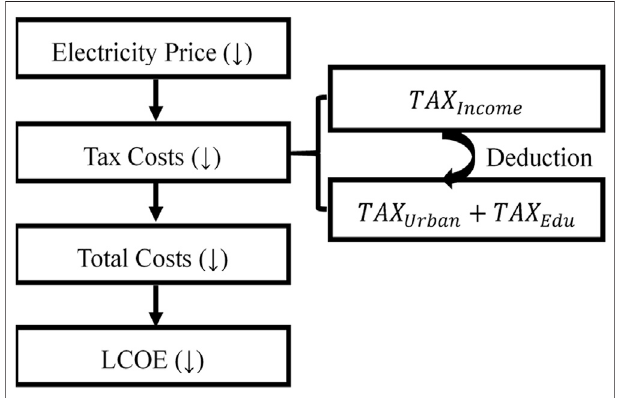
FIGURE 8 | Relationship among the electricity price, tax costs, total costs, and LCOE of the Pingluo project.